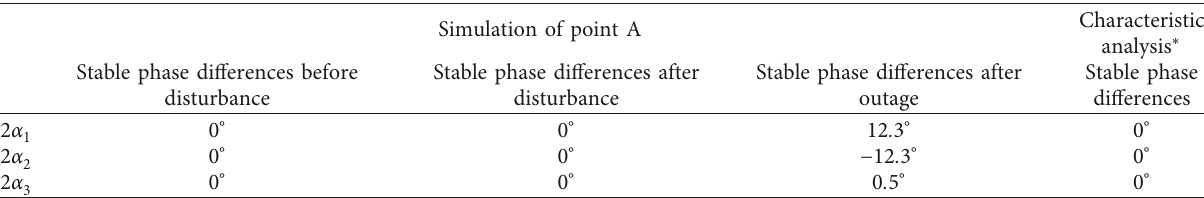
Table 1: The stable phase differences for η